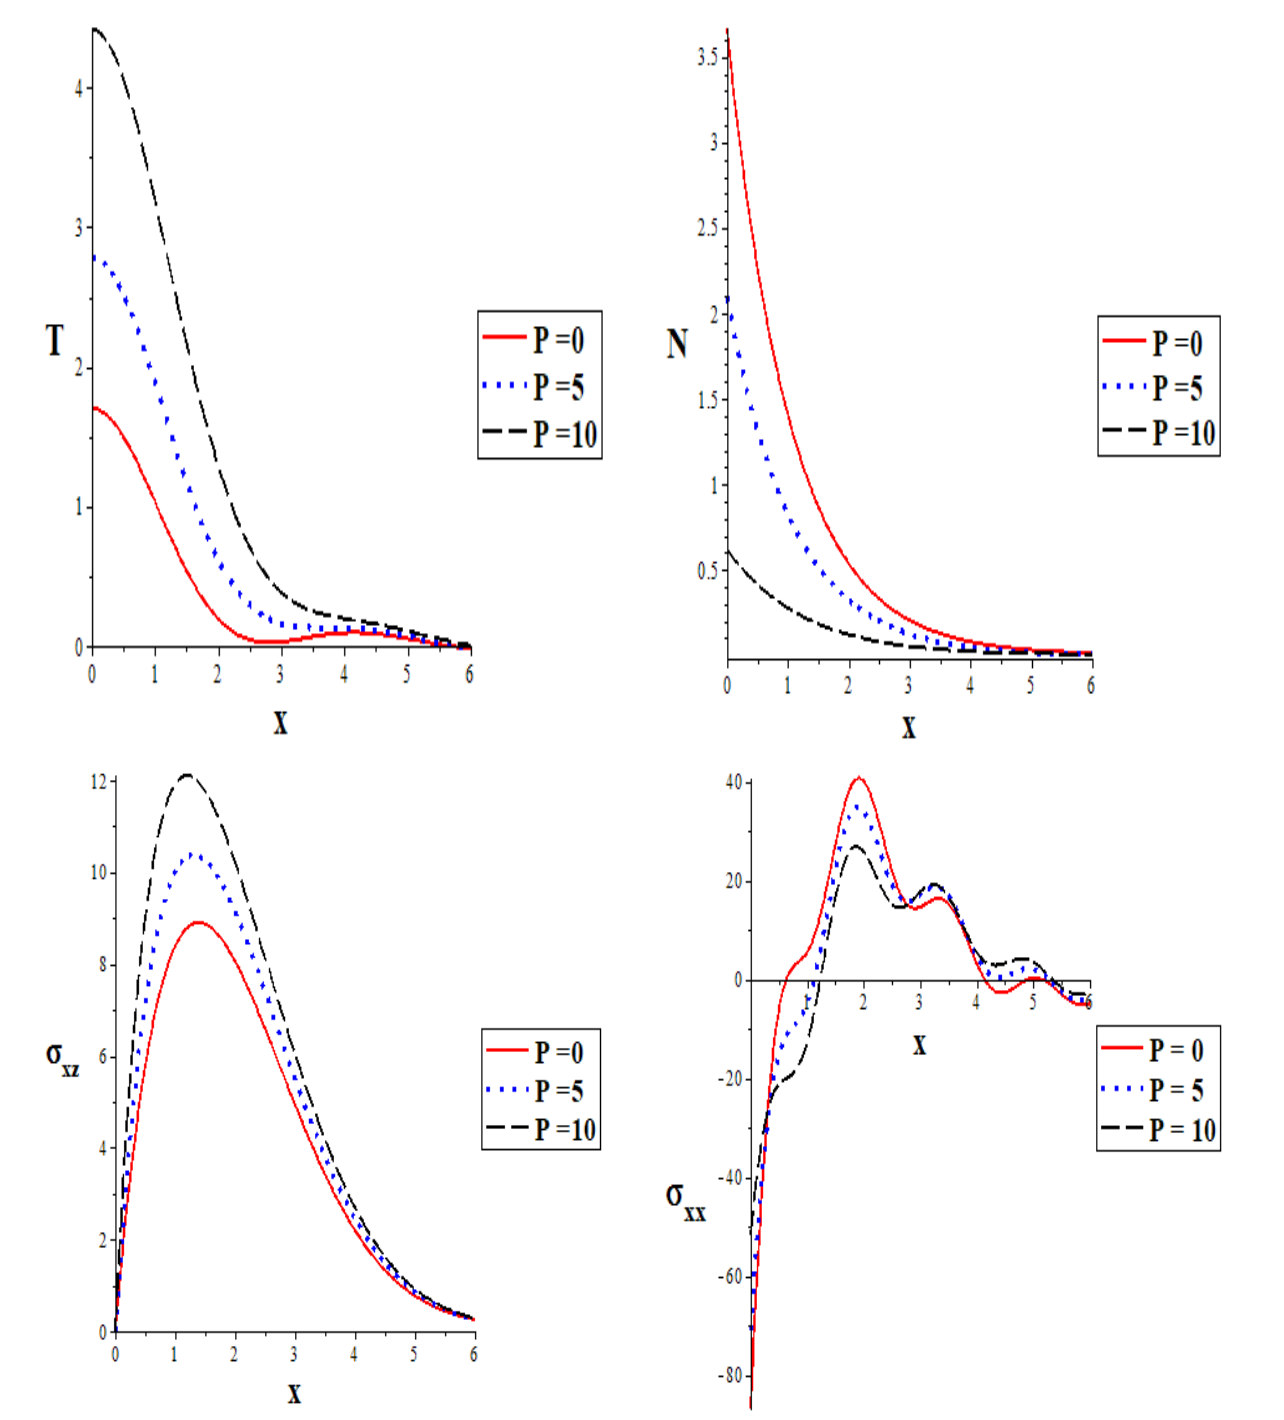
Figure 4. The main changes in the physical fields plotted against the horizontal distance for various values of initial hydrostatic stress in a rotational field according to the MGT model.